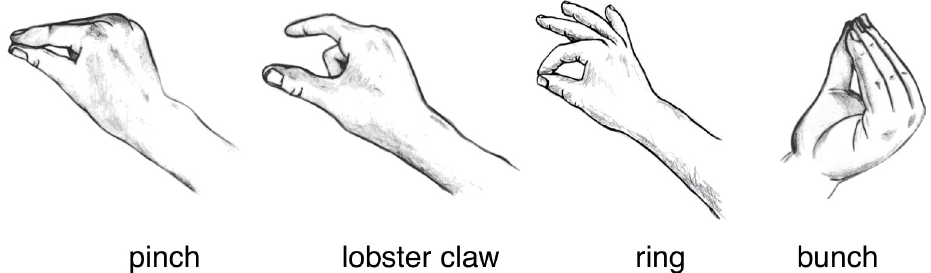
Fig 1. Illustrations of four different closed handshapes. The left three gestures involve precision grips (index finger and thumb approaching or touching each other). In what we call a ‘pinch’, the index finger and thumb are touching each other, or are held apart with a very narrow gap. In ‘lobster claw’ gestures, the index finger and thumb are held visibly apart. The ‘ring’ gesture is similar to the pinch, but with the middle, ring, and pinkie finger extended. For the ‘bunch’, speakers bring all fingers together, as if scraping together a heap of rice on a